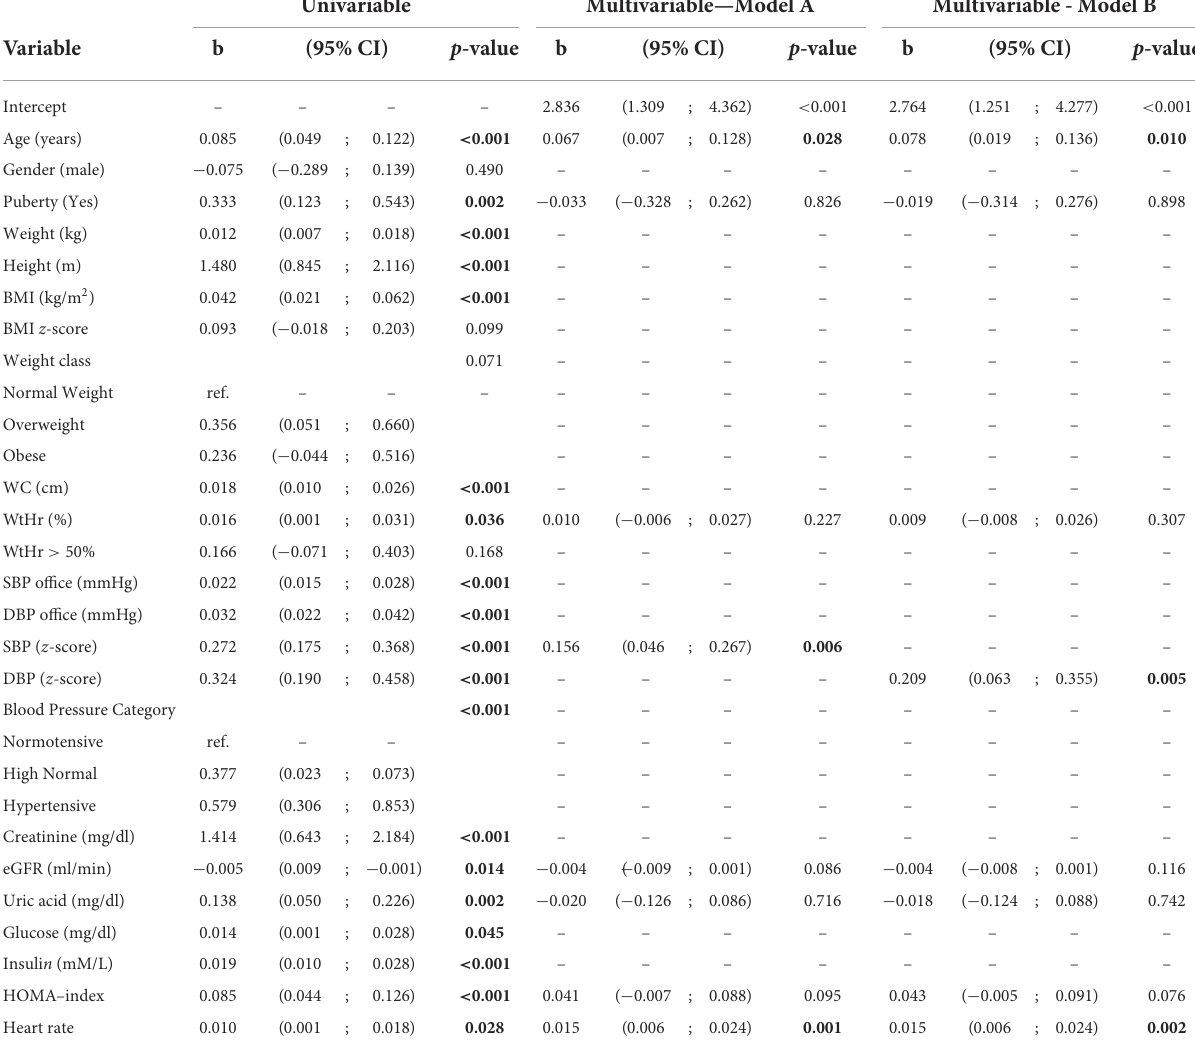
TABLE 2 Univariable and multivariable linear regression model on pulse wave velocity (m/s) – (Model A adjusted by SBP and Model B adjusted by